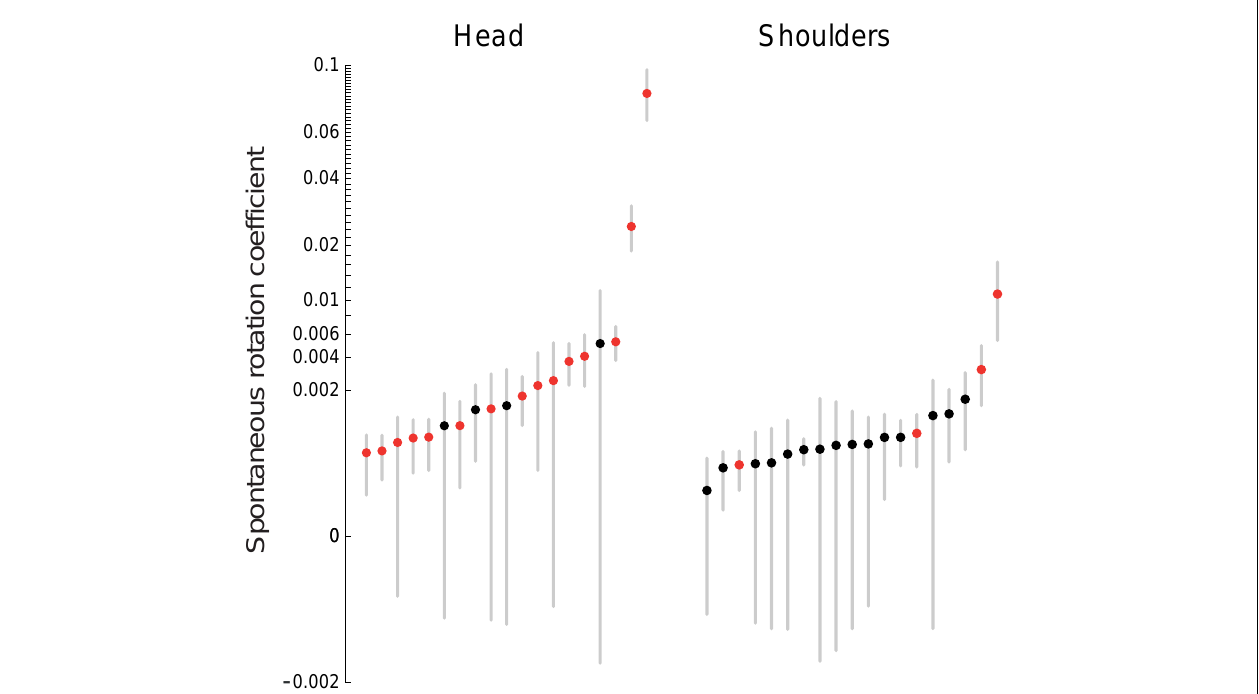
FIGURE 8 | Spontaneous rotation coefficients for the head and shoulders. The dots are the individual coefficients values of the participants shown in increasing order; red dots correspond to statistically significant coefficients ( p < 0.05).The error bars correspond to a measure of dispersion